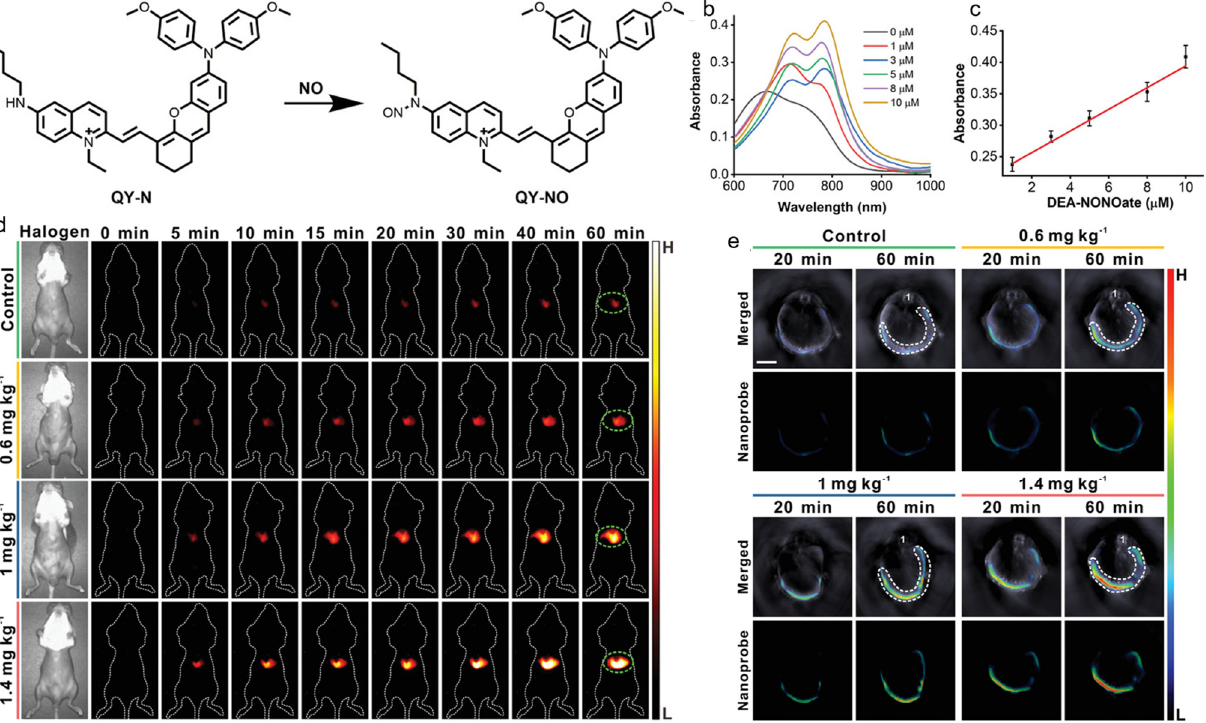
Figure 15. ( a ) The mechanism of BDNA for NO detection; ( b ) the formation of host–guest supramo- lecular complex BNDA–H β CD and the nanoprobe; ( c ) the BNDA@H β CD nanoprobe for in vivo